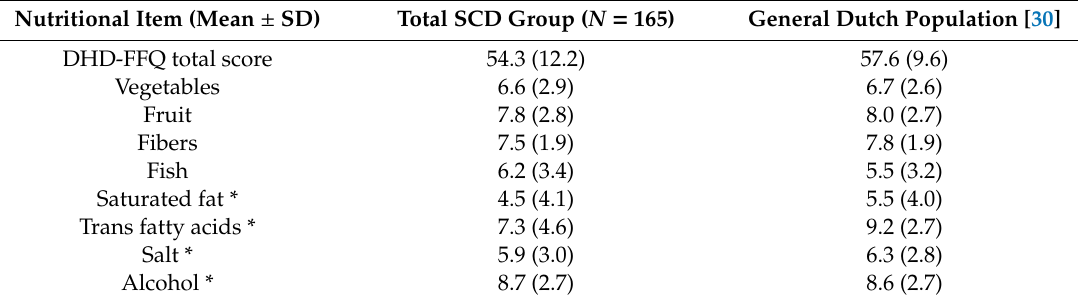
Table 1. Nutritional item scores of the total